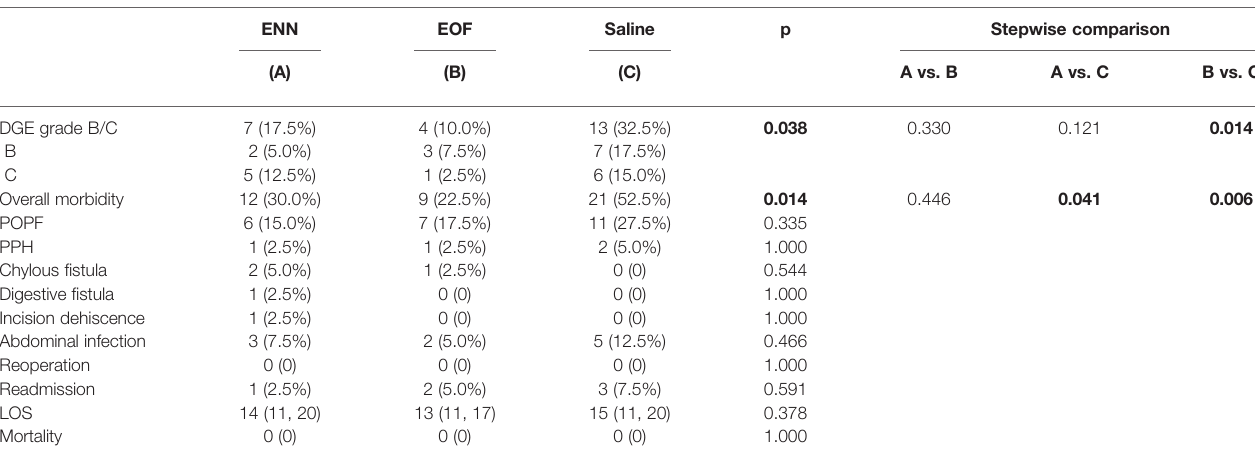
TABLE 3 | Postoperative outcomes.